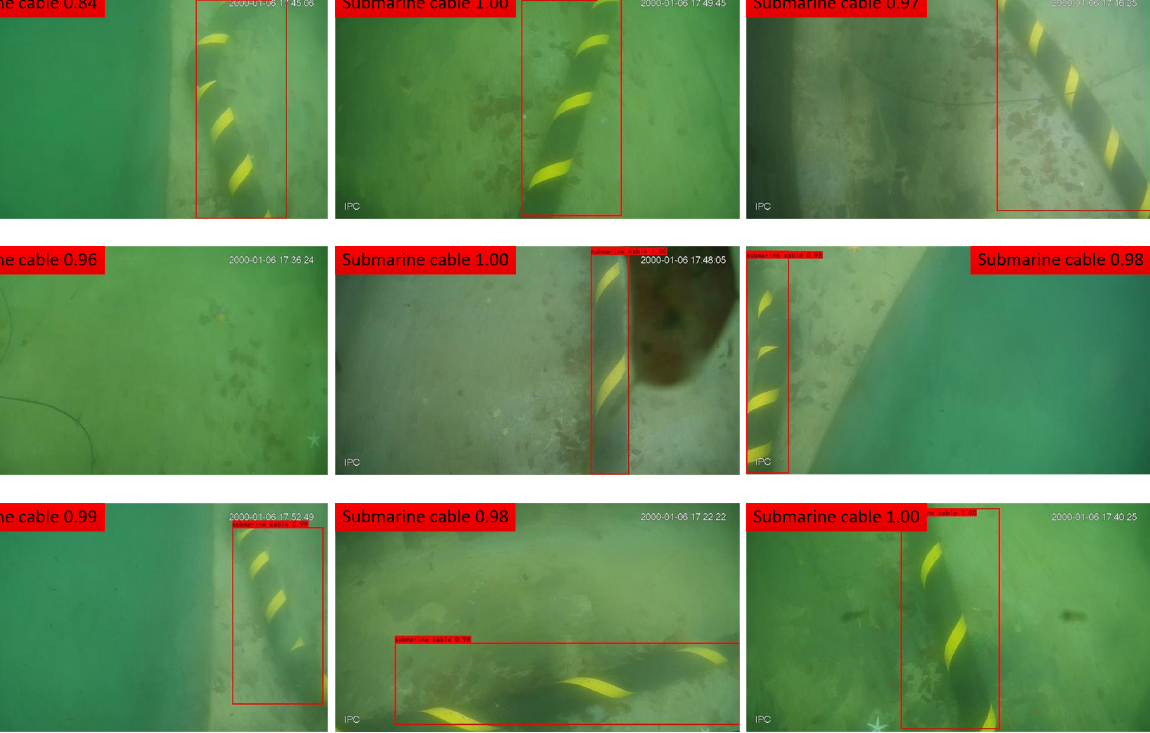
Figure 12. YOLO-SC model: example of the actual measurement